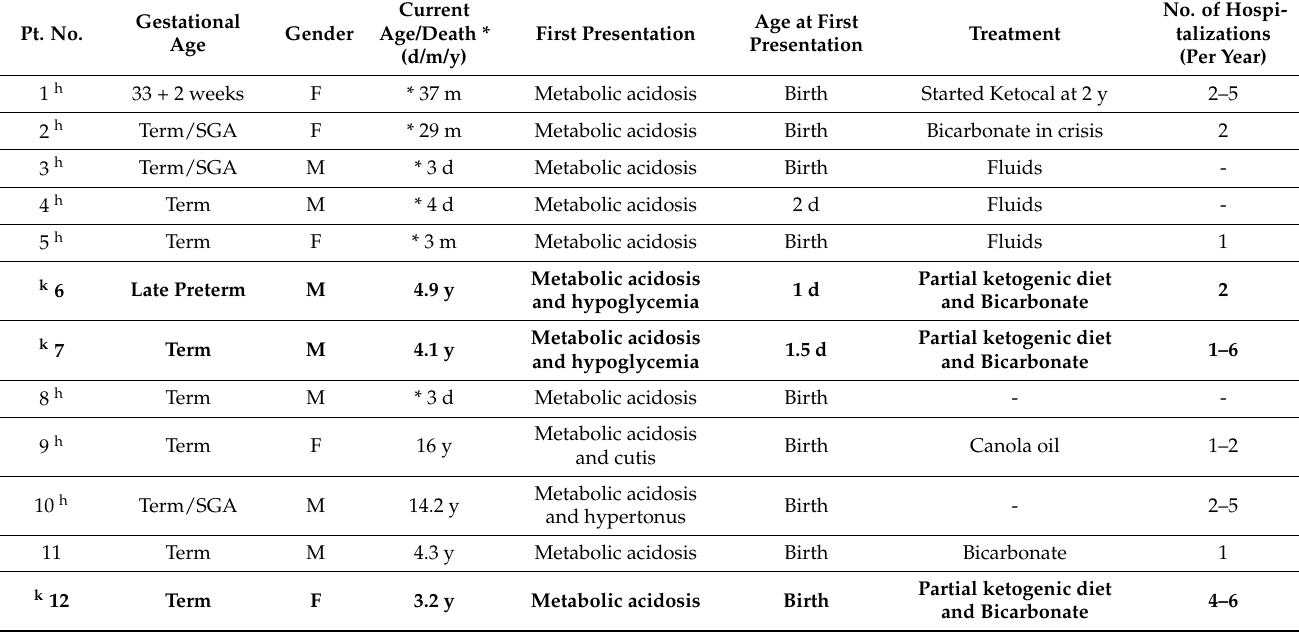
Table 2. Demographic and clinical characteristics of patients with dihydrolipoamide dehydrogenase deficiency. Patients treated with partial ketogenic diet appear in